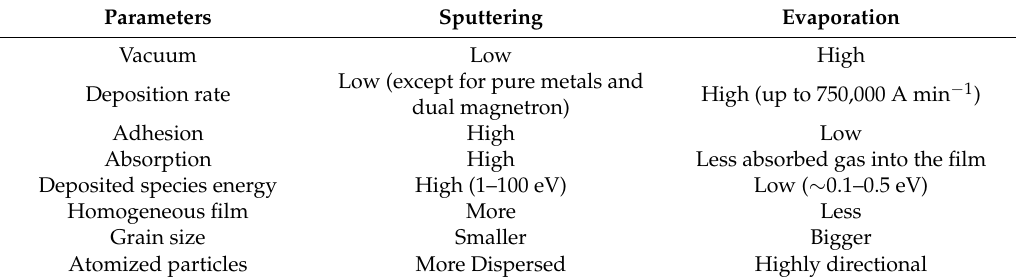
Table 1. Typical features of the PVD